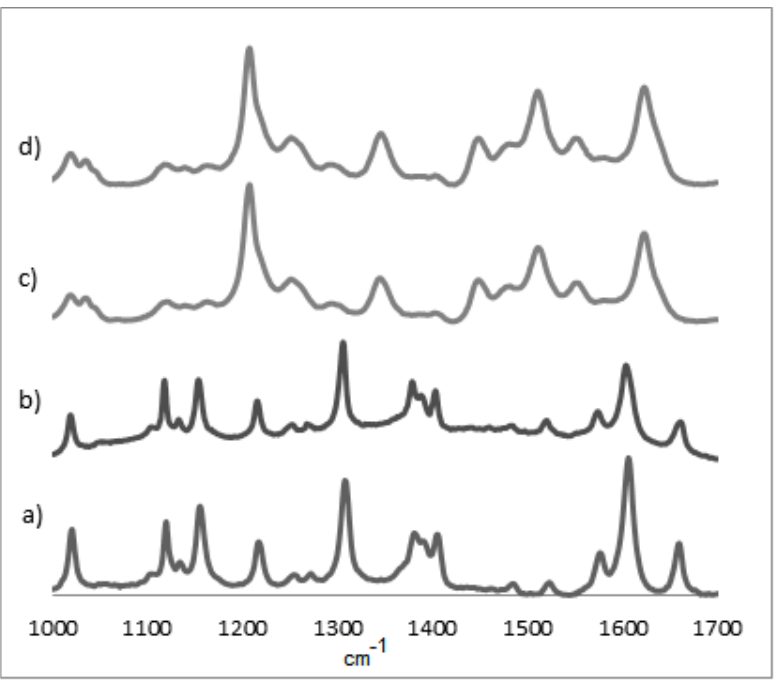
Figure 4. Raman spectra of NiOEP films on ITO surface: ( a ) reference porphyrin without electropolymerization; ( b ) potential range − 1.0 V to 1.7 V; ( c ) potential range 0.0 V to 1.6 V; and ( d ) potential range 0.0 V to 2.2 V (excited at 532.0 nm). Table 3. Frequencies (cm − 1 ) of selected Raman bands for the polymers/monomers of metallo- octaethylporphyrins on ITO (excited at 532.0 nm) at the different potential